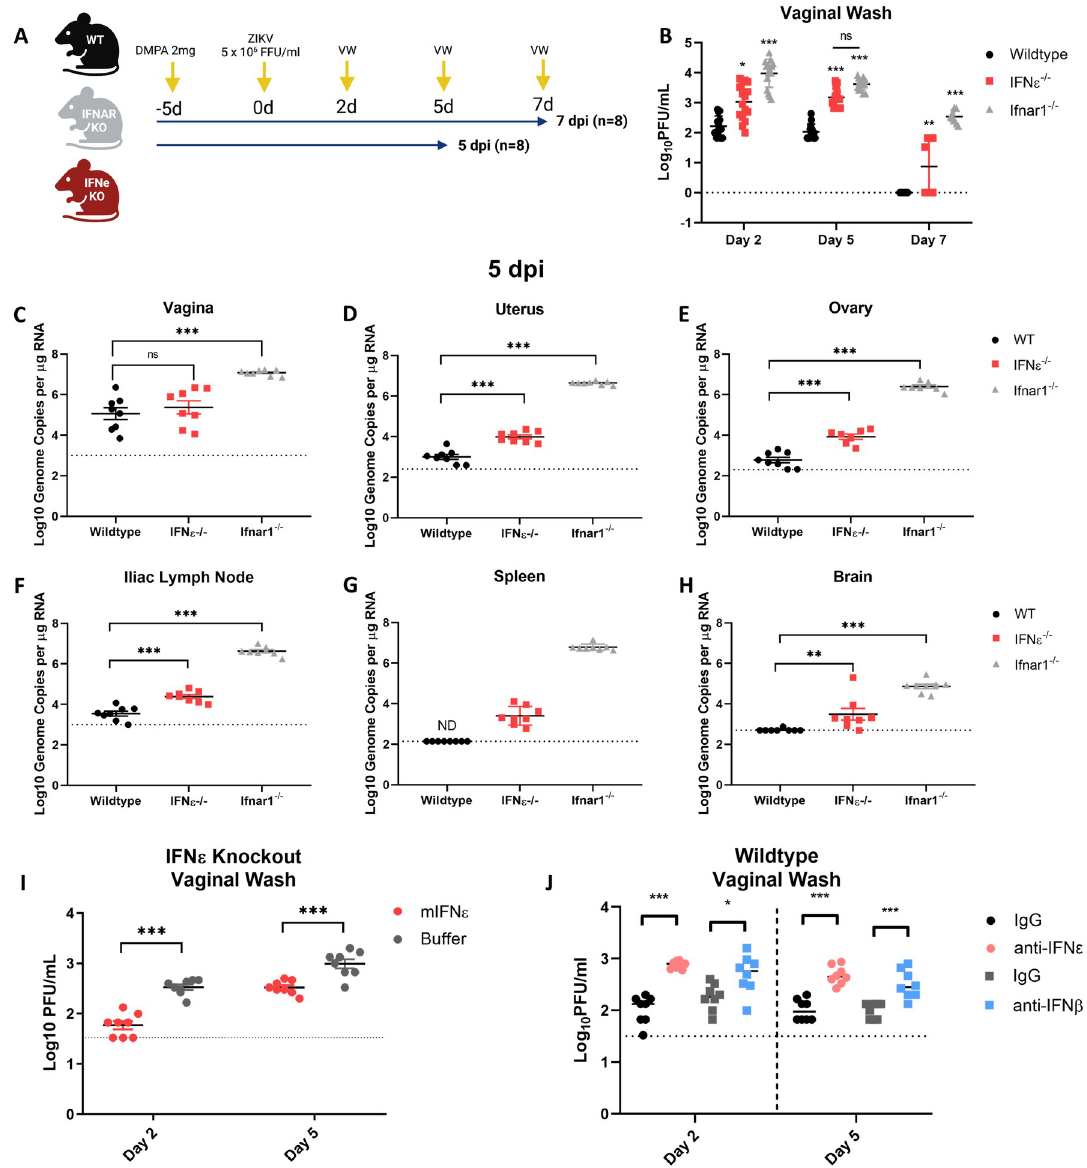
Fig 1. ZIKV replication is inhibited by IFN ε in a mouse model of vaginal transmission. A) Experimental timeline of WT (black), mice lacking IFN ε (IFN ε -/-) (red) or mice lacking the type-I IFN receptor (IFNAR1-/-) (grey) were infected with ZIKV at 5 x 10 5 FFU iVag 5 days post DMPA treatment and vaginal washes were taken at 2, 5, 7 dpi. Groups of 8 mice were culled at 5 dpi and 8 were culled at 7 dpi. B) Infectious virus was measured from vaginal washes by plaque assay at 2, 5, 7 dpi. C, D, E, F, G & H) Tissues taken at 5 dpi were used to harvest RNA for analysis of viral RNA by qRT-PCR in the vagina, uterus, ovary, illiac lymph node spleen and brain respectively. I) IFN ε -/- mice were treated for 6h with either mIFN ε or buffer prior to iVag infection with ZIKV, Infectious virus was measured from vaginal washes by plaque assay at 2 and 5 dpi. J) WT mice were treated for 6h with either an IFN ε neutralising antibody ( α -IFN ε ),an IFN β ( α -IFN β ) neutralising antibody, or a matched isotype control prior to iVag infection with ZIKV. Infectious virus was measured from vaginal washes by plaque assay at 2 and 5 dpi. Statistical analyses were performed on log10 transformed data using one-way ANOVA for multiple comparisons or t-test for two group comparisons. Data are presented as the mean +/- S.E.M. Schematic created with